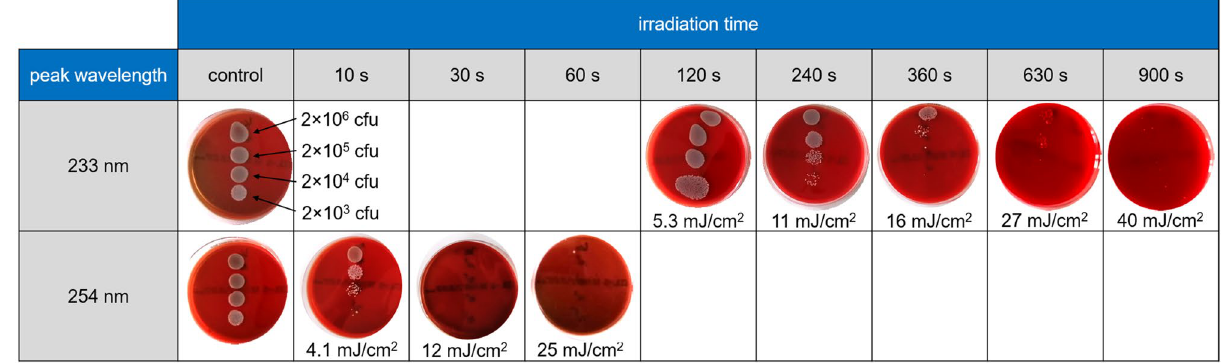
Figure 3. Columbia blood agar plates inoculated with different concentrations of bacterial suspension (MRSA, DSM 11822) without and with UVC irradiation for different times using either far-UVC (233 nm) or near-UVC (254 nm) radiation and after incubation for 24 h. The numbers below the plates indicate the applied UV